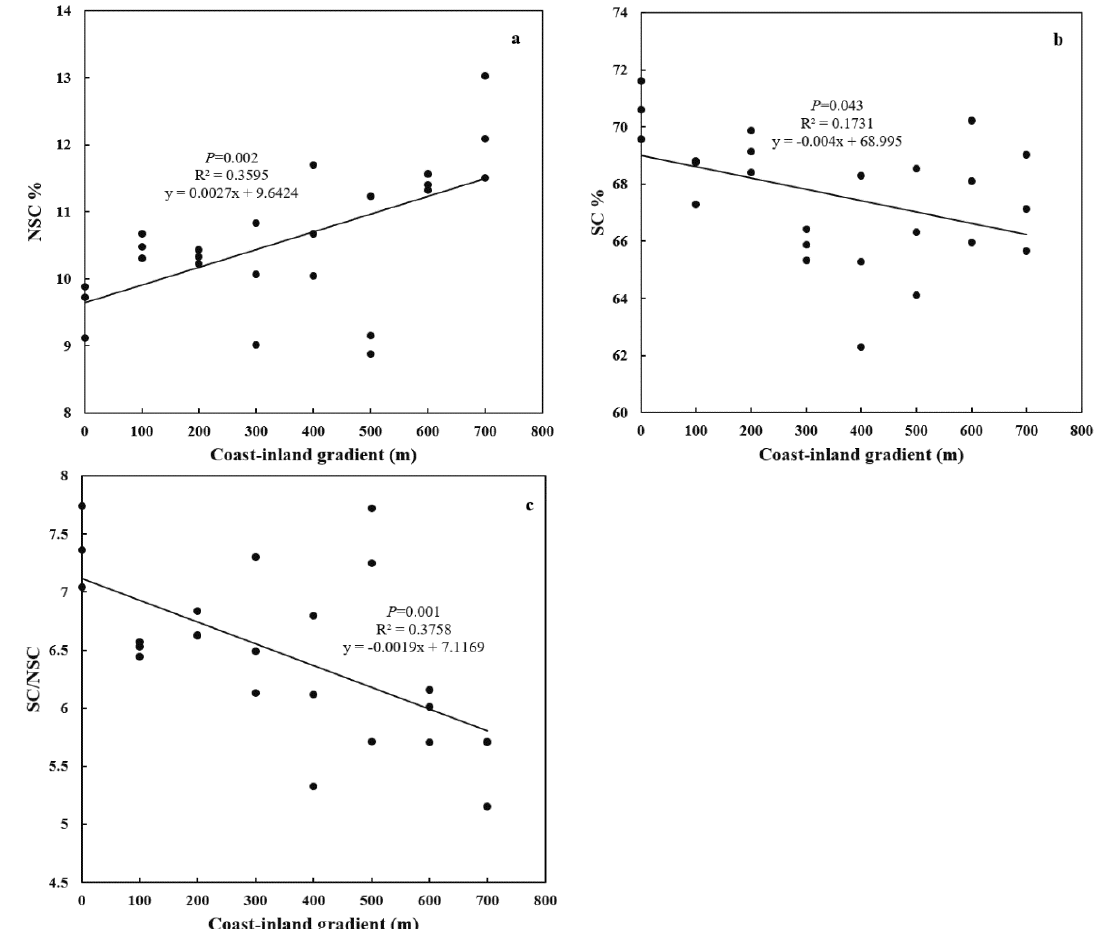
Figure 2. Variations in Y(II) for P. thunbergii along the coast-inland gradient.